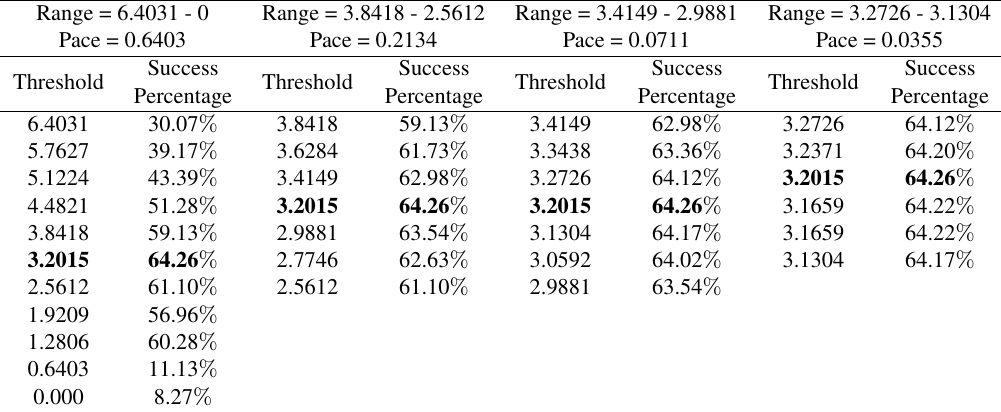
Table 2: Results of threshold selection with the Double-window Flexible Pace Search (DFPS).